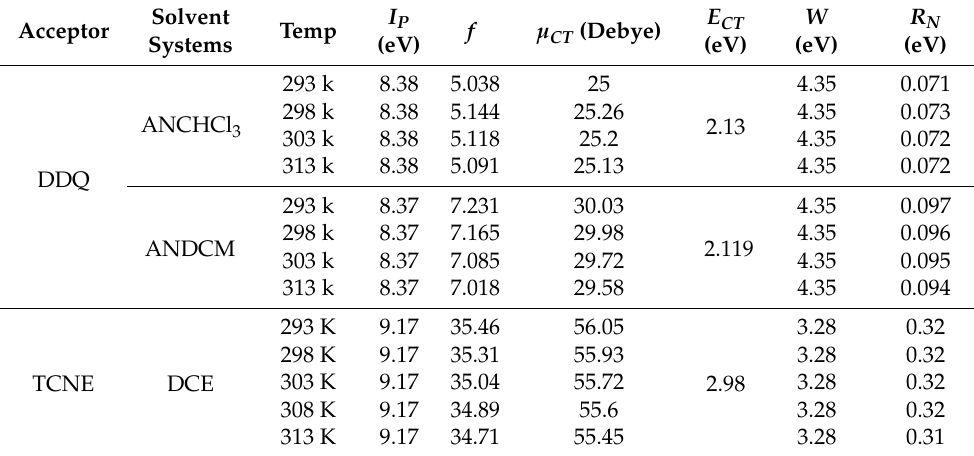
Table 4. The spectroscopic data of the CT complexes in different solvents systems at different